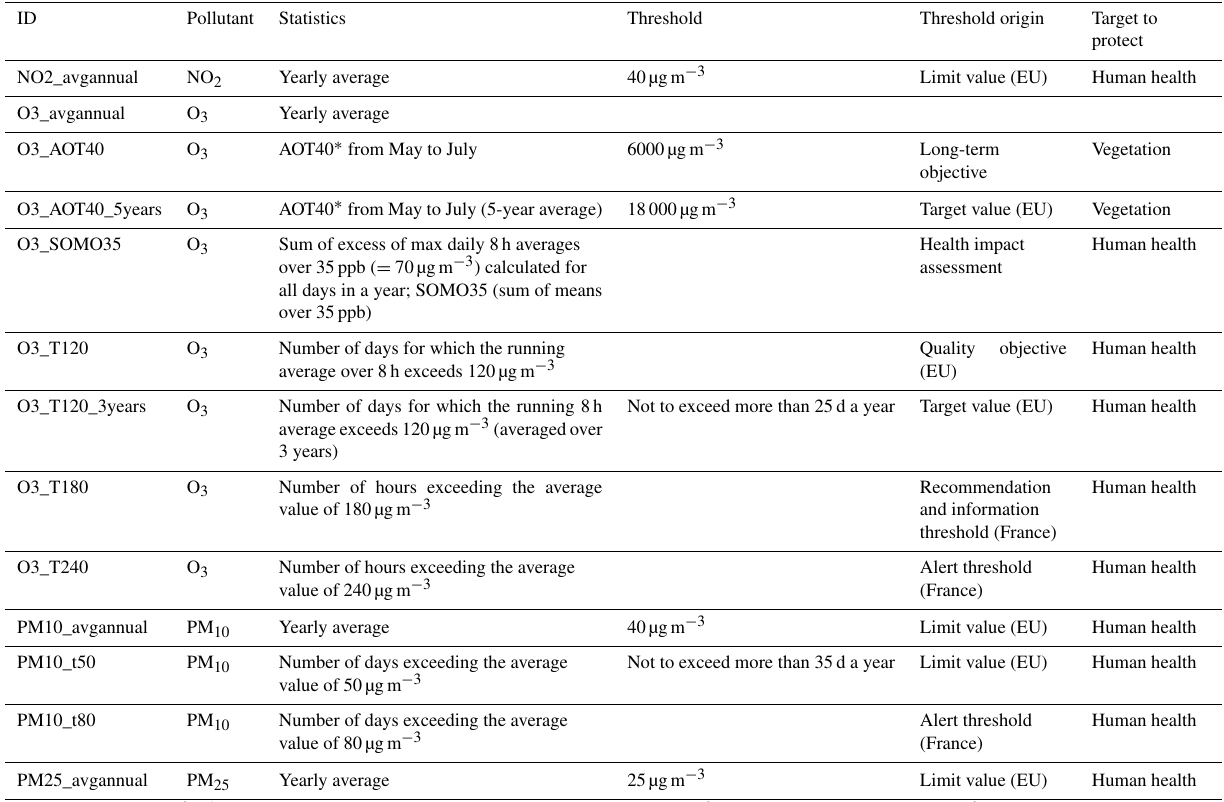
Table 2. Yearly regulatory air quality indicators from EU legislation or French legislation and usual indicators.